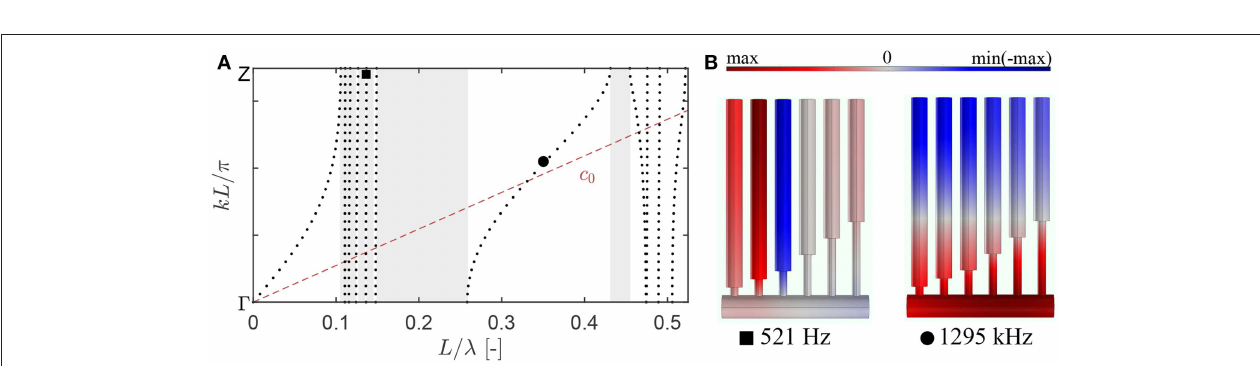
FIGURE 3 | (A) The dispersion relation for a periodic arrangement of the six detuned HRs on a tube. The shaded regions indicate band gaps with inhibited wave propagation. The dashed line c 0 describes a propagating band of sound waves in free air. (B) The pressure distribution at frequencies indicated in (A) .